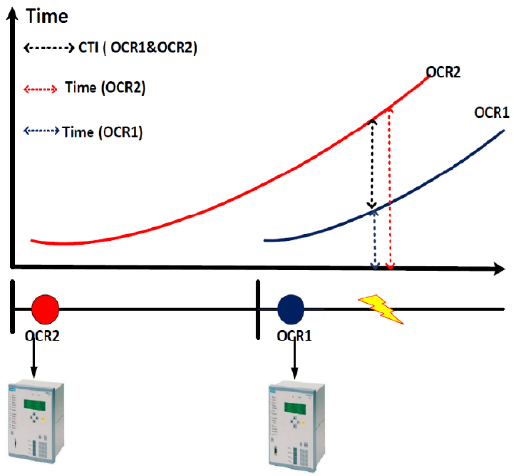
Figure 2. Coordination Constraint between Primary and Backup relay.